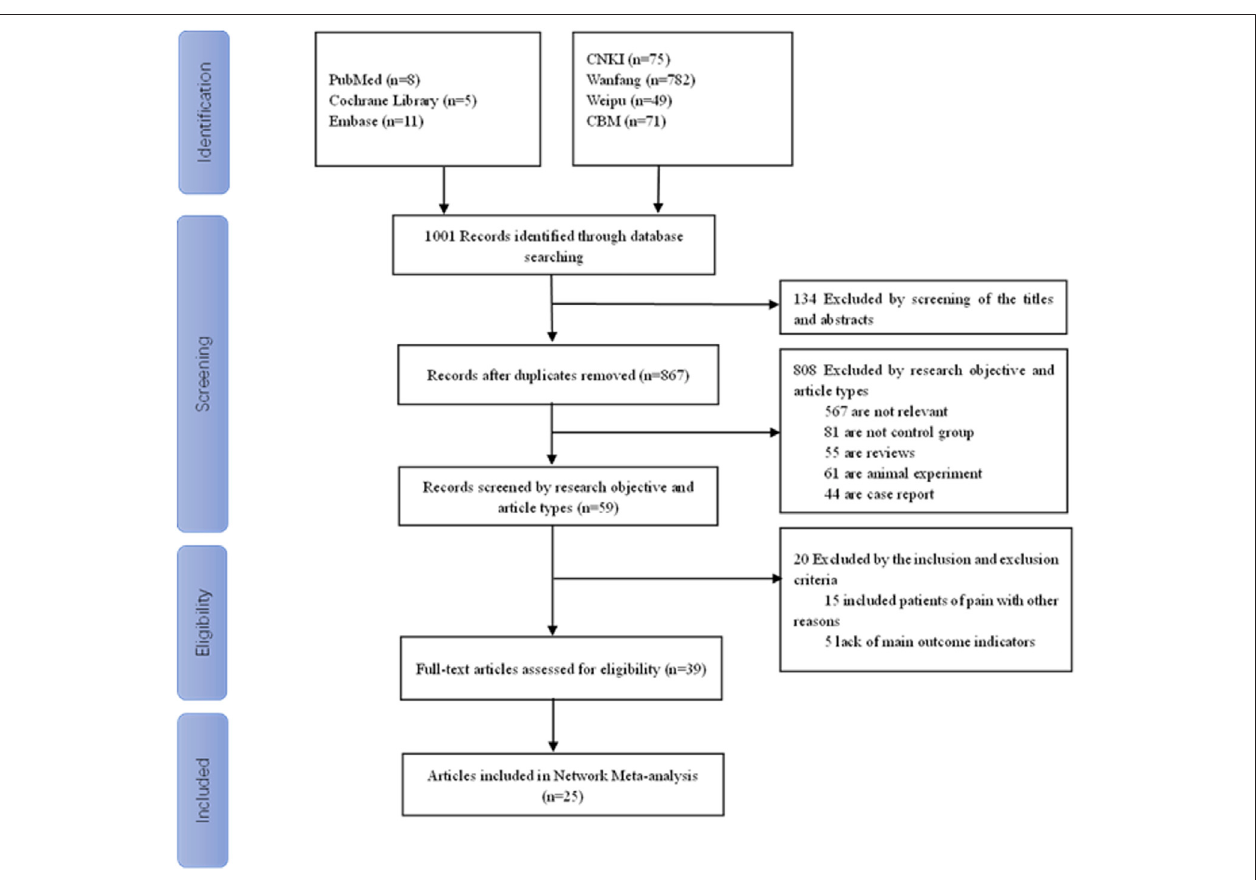
FIGURE 1 | Flow chart of the study selection